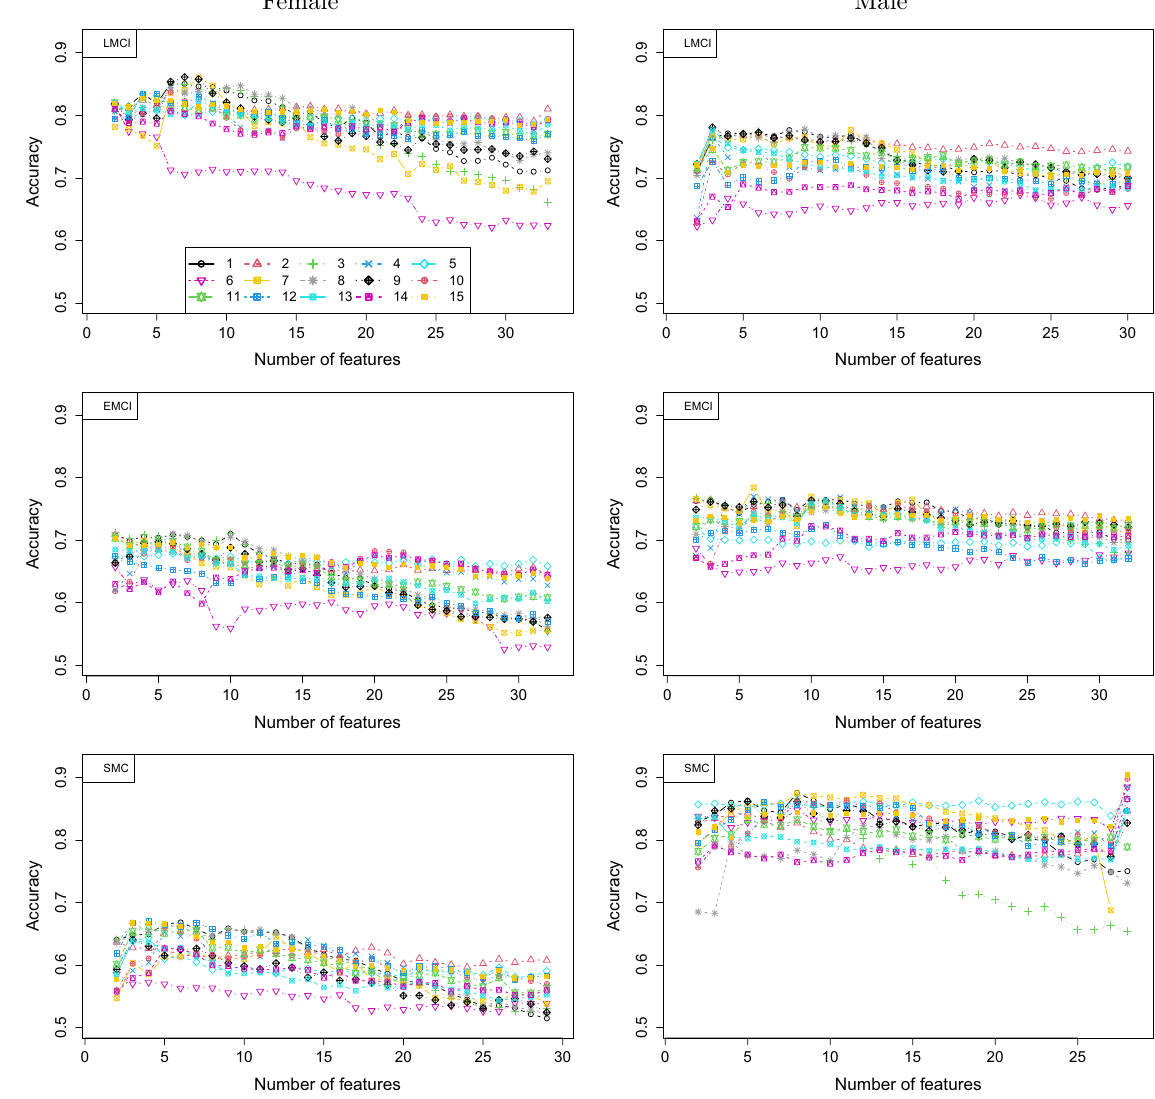
Figure 1. Accuracy of the 15 ML methods using the domain scores for the 6 subgroups stratified by diagnosis and sex.